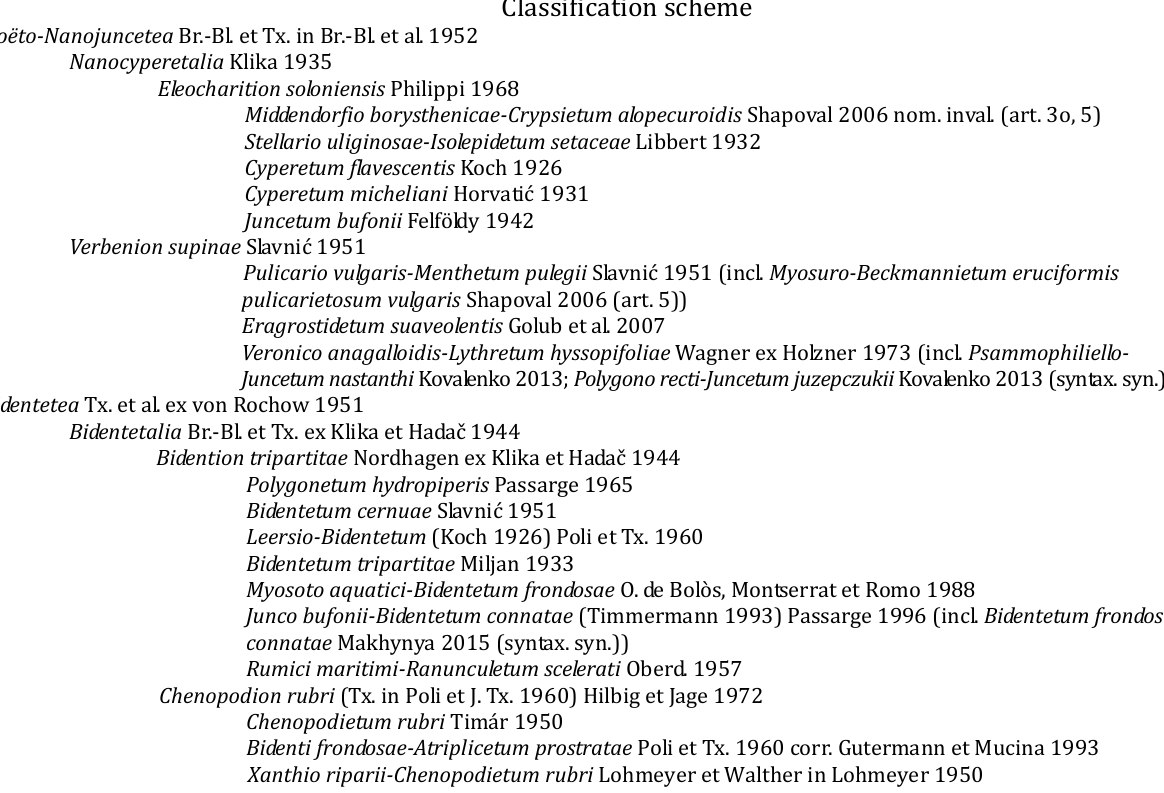
represented by 2 orders: Isoëtetalia Br.-Bl. 1935 and Nanocyperetalia Klika 1935, and 11